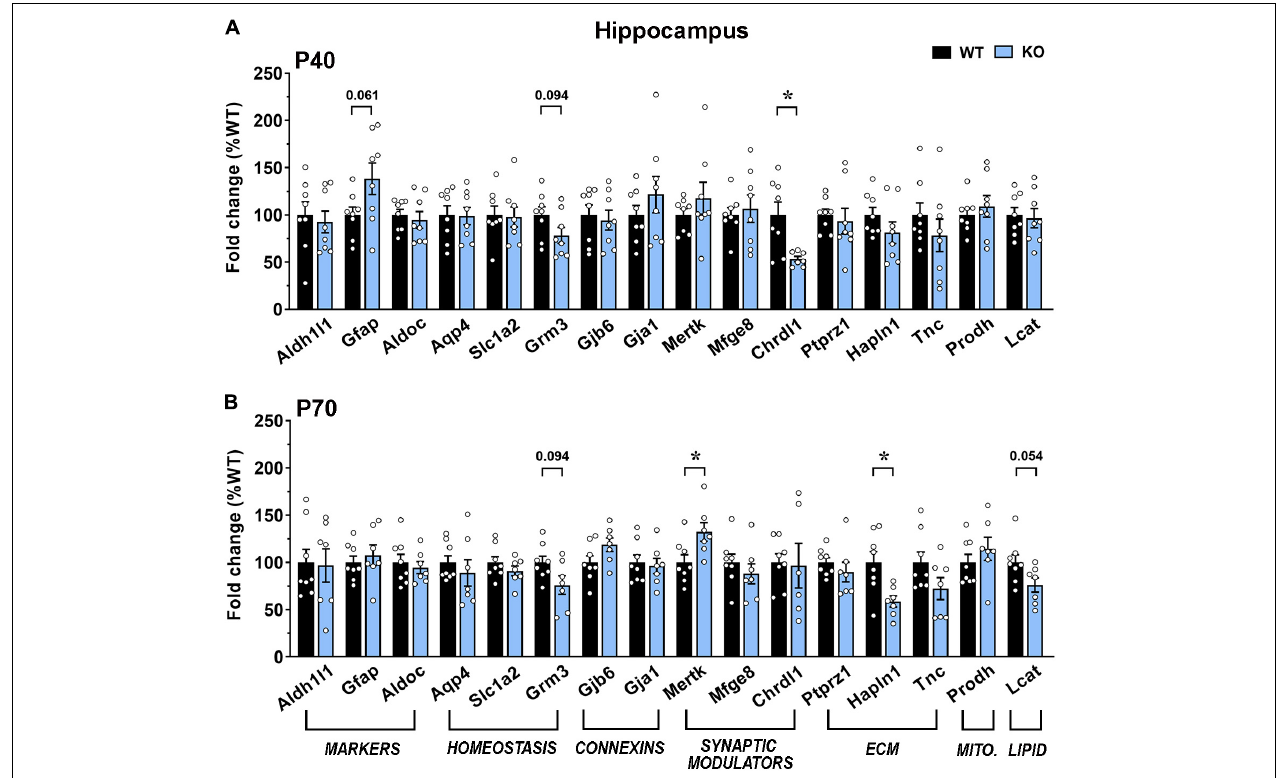
FIGURE 8 | Transcriptional expression of astrocytic genes in the dorsal hippocampus of moderate and severe symptomatic Mecp2 KO animals. (A,B) The graphs depict the mRNA expression of selected astrocytic genes in motor cortex of moderate [at P40 (A) ] and severe symptomatic [at P70 (B) ] KO mice, compared to the corresponding WT littermates. Data are represented as mean ± SEM. * p < 0.05 by Student’s t -test or Mann–Whitney test in accordance with data distribution. Eight animals per genotype were used at each time point ( N =